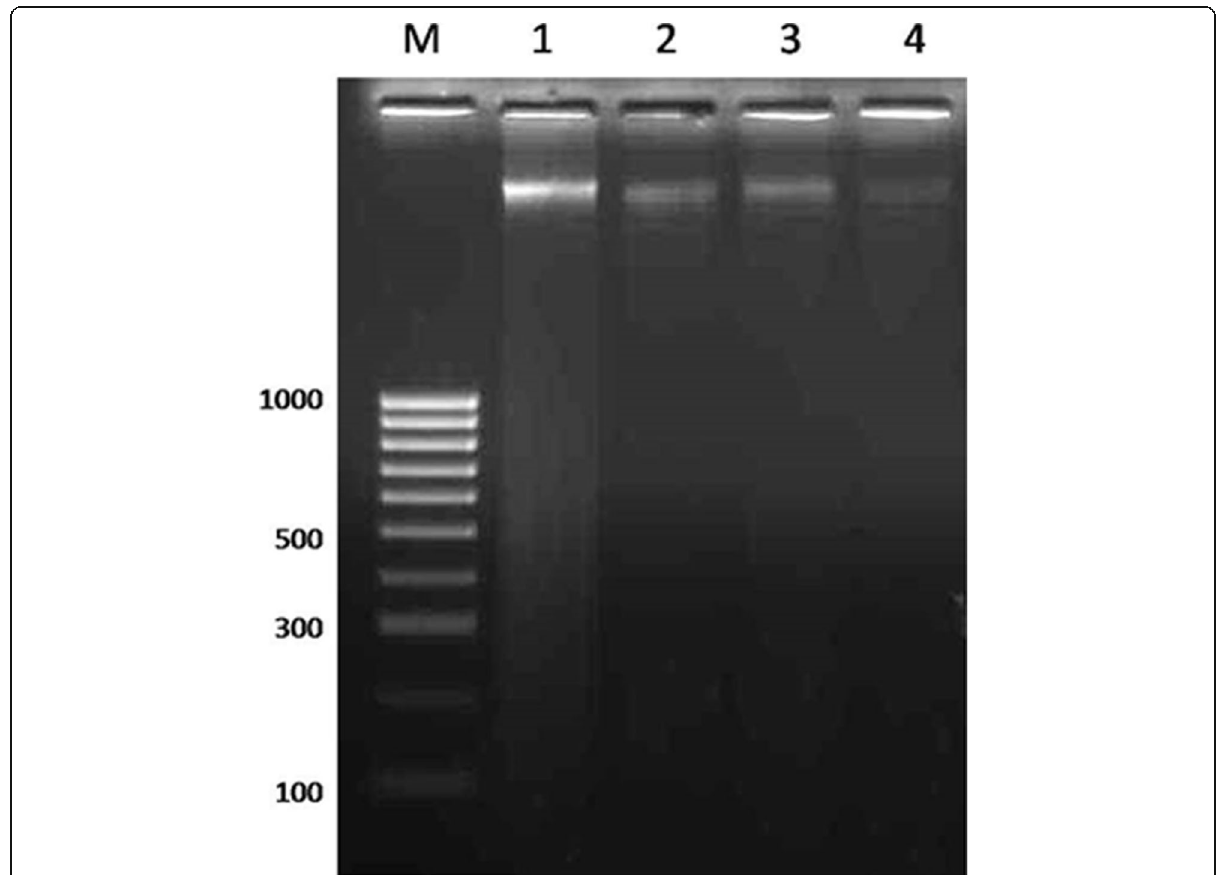
Fig. 5 Effect of Ag-BSEPS on the liver DNA in fibrotic rats; Lane 1 (Marker), 2 (Control), 3 (TAA-treated rats), 4 (TAA + 100 mg/kg B.W. Ag-BSEPS)